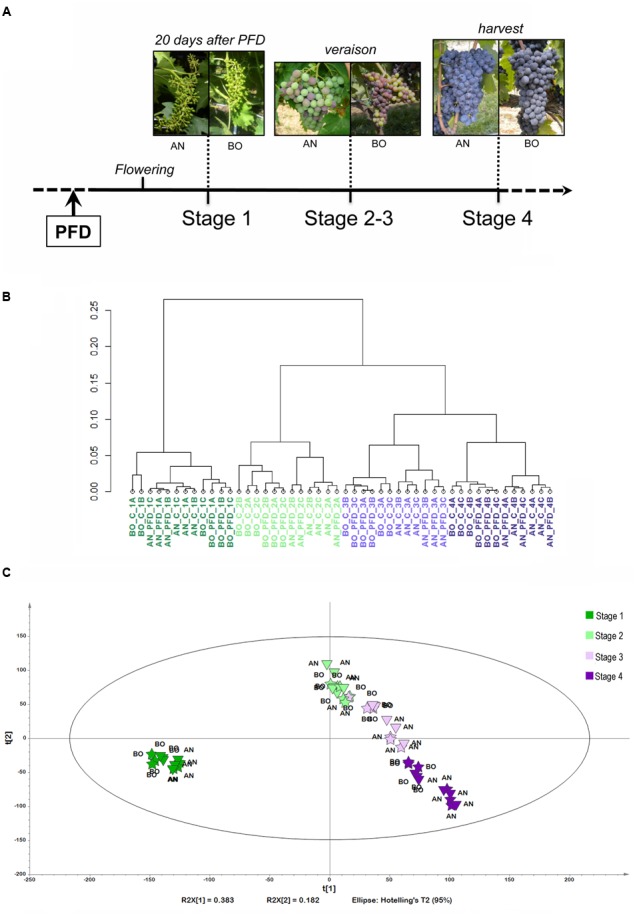
Whole transcriptome analysis of Sangiovese berries subjected to PFD treatment in two different sites. (A) Schematic representation of the sampling design used. (B) Cluster dendrogram of the whole transcriptome dataset in all analyzed samples. Pearson’s correlation values were converted into distance coefficients to define the height of the dendrogram. Samples are colored according to the developmental stage of sampling. (C) Score scatterplot (PC1 vs. PC2) of the PCA model (9 Principal Components, R2(cumulative) = 0.903, Q2(cumulative) = 0.848) applied to the significantly modulated transcripts dataset. Samples are colored according to the developmental stage of sampling. Different treatments are indicated by different symbols, “ding73” = Control and “” = Pre-flowering defoliation.